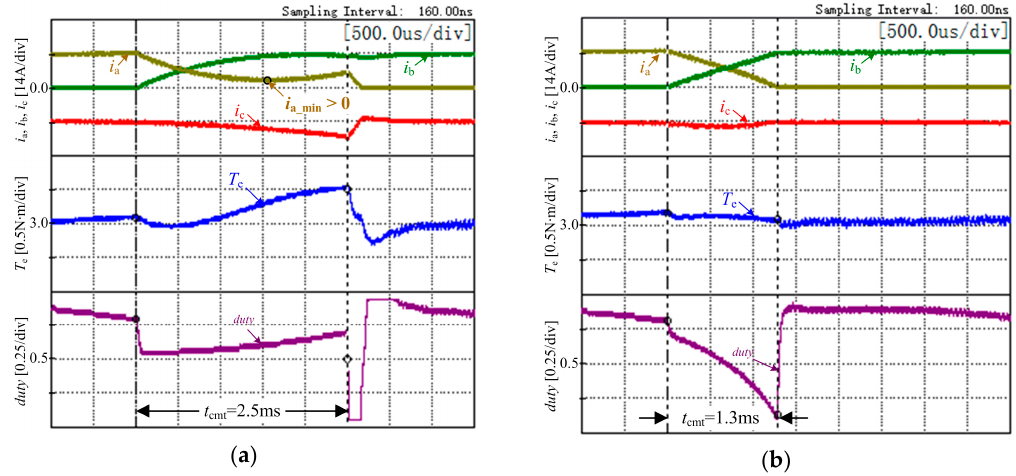
Figure 11. Enlarged waveforms of the commutation process under the rated load at 550 r/min. ( a ) the traditional strategy. ( b ) the proposed strategy.